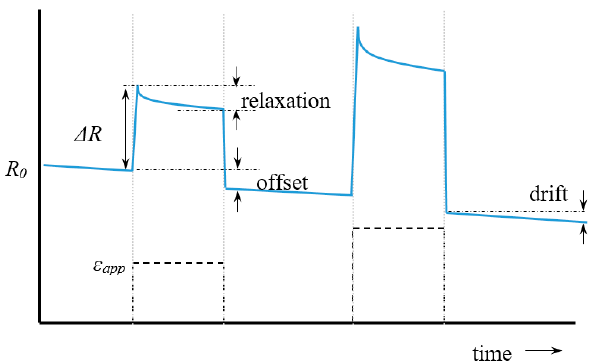
Figure 4. Schematic response of sensor after applied strain steps (black pulses).